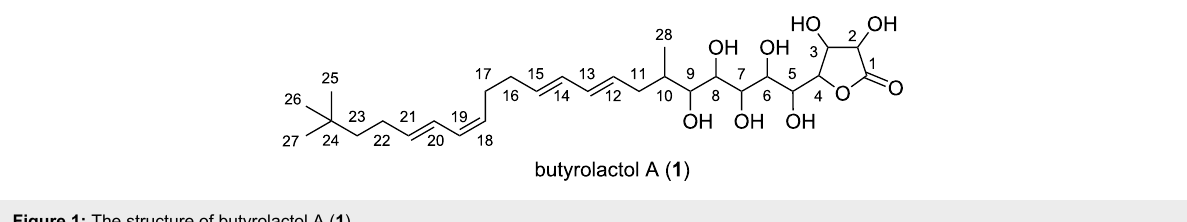
Figure 1: The structure of butyrolactol A ( 1 ).